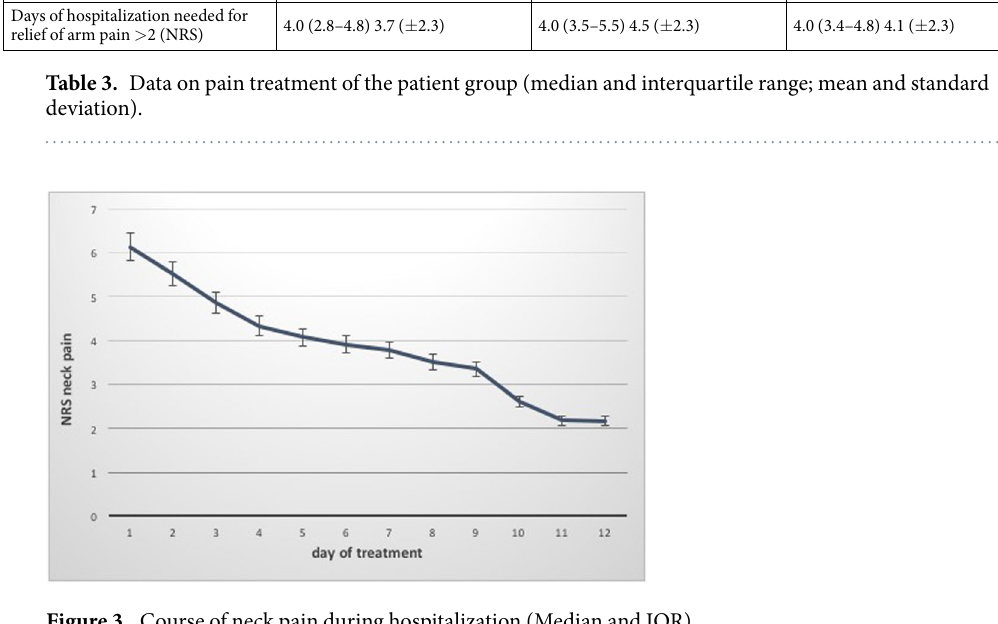
Figure 3. Course of neck pain during hospitalization (Median and